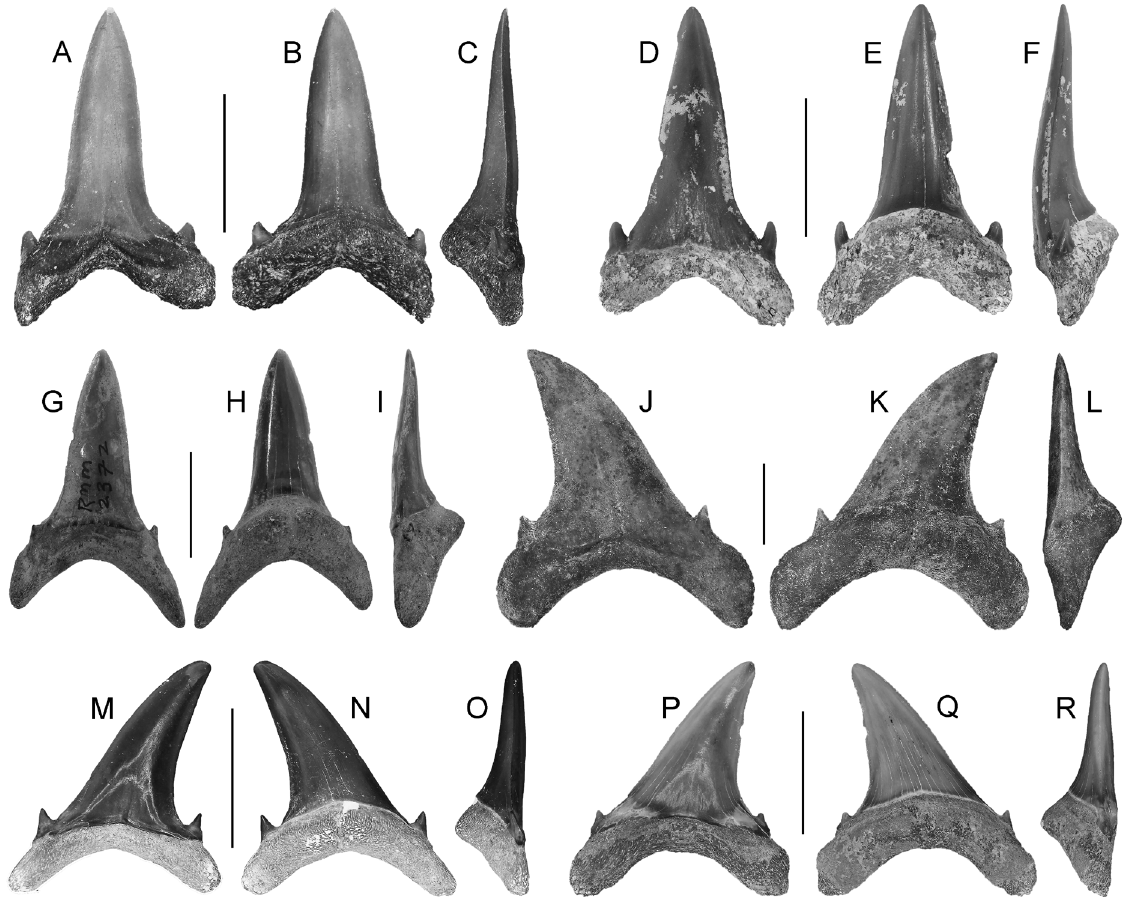
Fig. 16. Jaekelotodus robustus (Leriche, 1921), teeth. A–C . MSC 35740.1, anterior tooth, Meridian Sand Member of the Tallahatta Formation. A . Labial view. B . Lingual view. C . Mesial view. D–F . MSC 33371, anterior tooth (lower Tallahatta Formation). D . Labial view. E . Lingual view. F . Mesial view. G–I . MSC 2372.11, anterior tooth, Gosport Sand. G . Labial view. H . Lingual view. I . Mesial view. J–L . MSC 37149, upper lateral tooth, Tallahatta/Lisbon formation contact zone, courtesy of James Lowery. J . Labial view. K . Lingual view. L . Mesial view. M–O . MSC 33932, upper lateral tooth, lower Tallahatta Formation. M . Labial view. N . Lingual view. O . Mesial view. P–R . MSC 35783.1, upper lateral tooth, lower Tallahatta Formation. P . Labial view. Q . Lingual view. R . Mesial view. Scale bars = 1